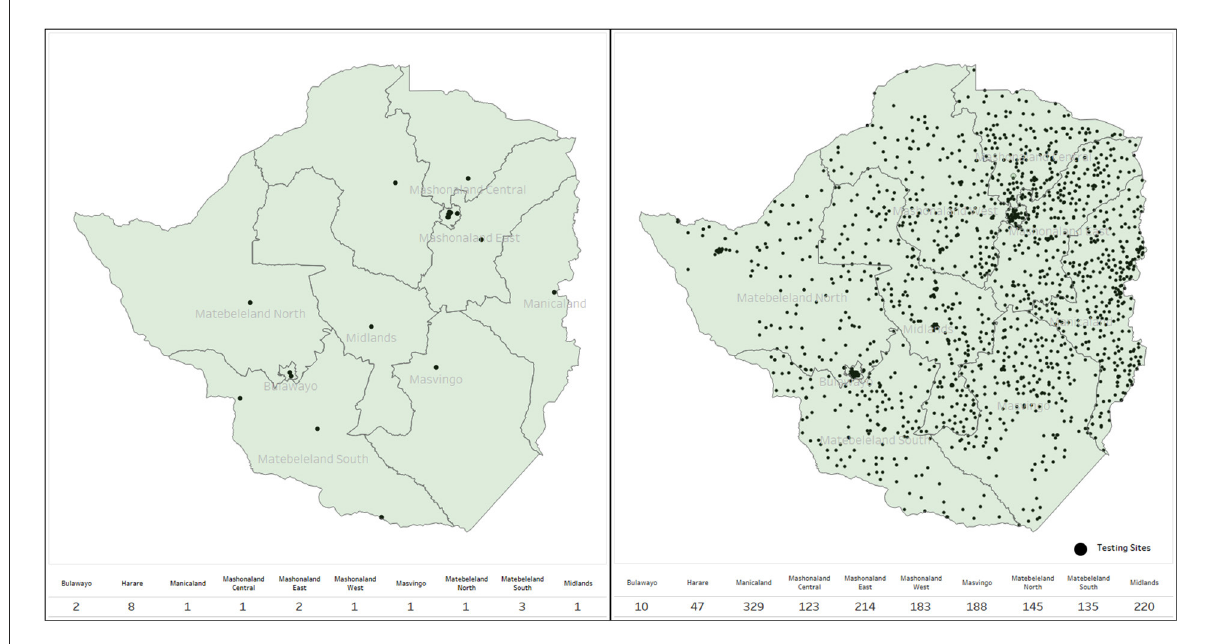
FIGURE4 Spot map showing scale-up of testing sites increasing